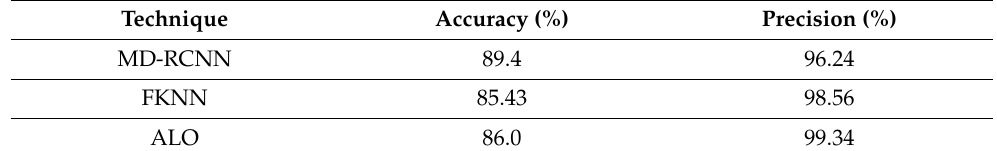
Table 2. Accuracy and precision analysis.